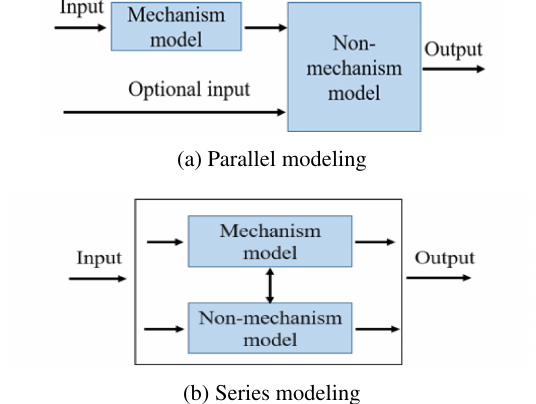
Fig. 2 Schematic of the hybrid model construction